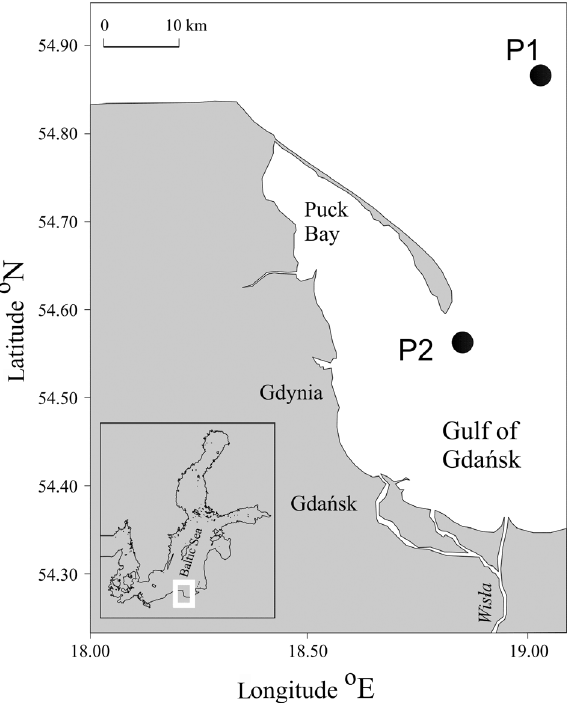
Fig. 1. Location of stations for which the numerical simula- tions were performed; P1 – the Gda ń sk Deep, P2 – the Gulf of Gda ń